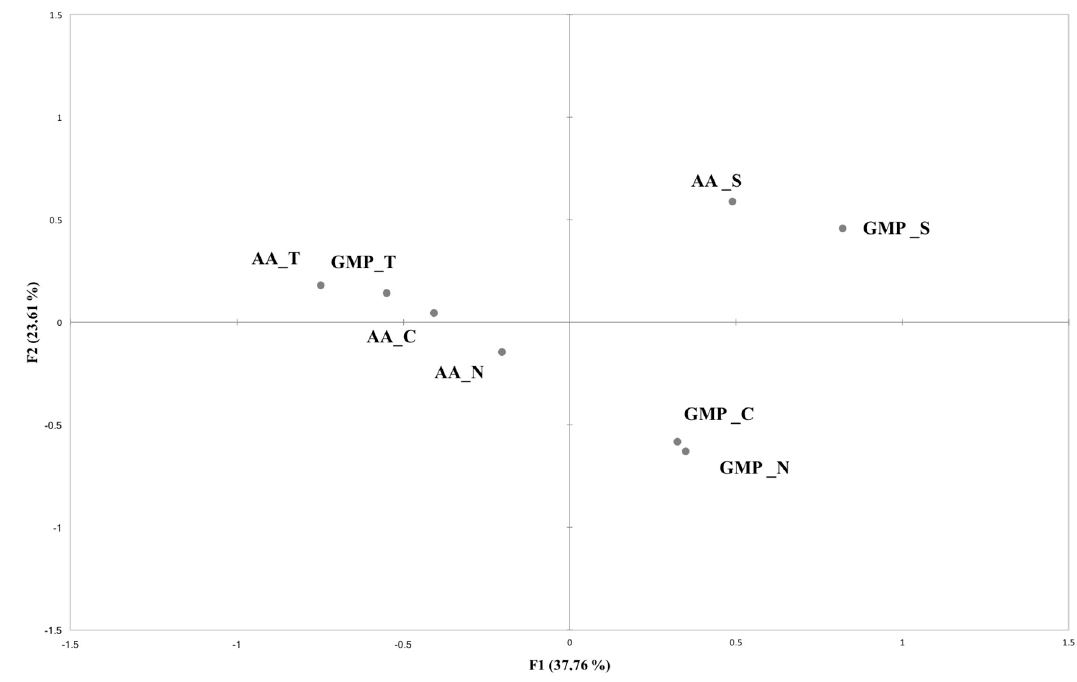
Figure 5. Products plot obtained from Check-all-that-apply (CATA).